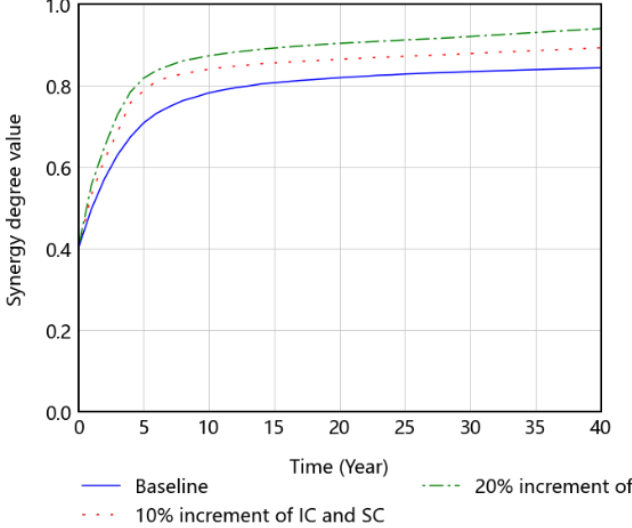
Figure 16. The effects of different degrees of IC and SC on synergy.